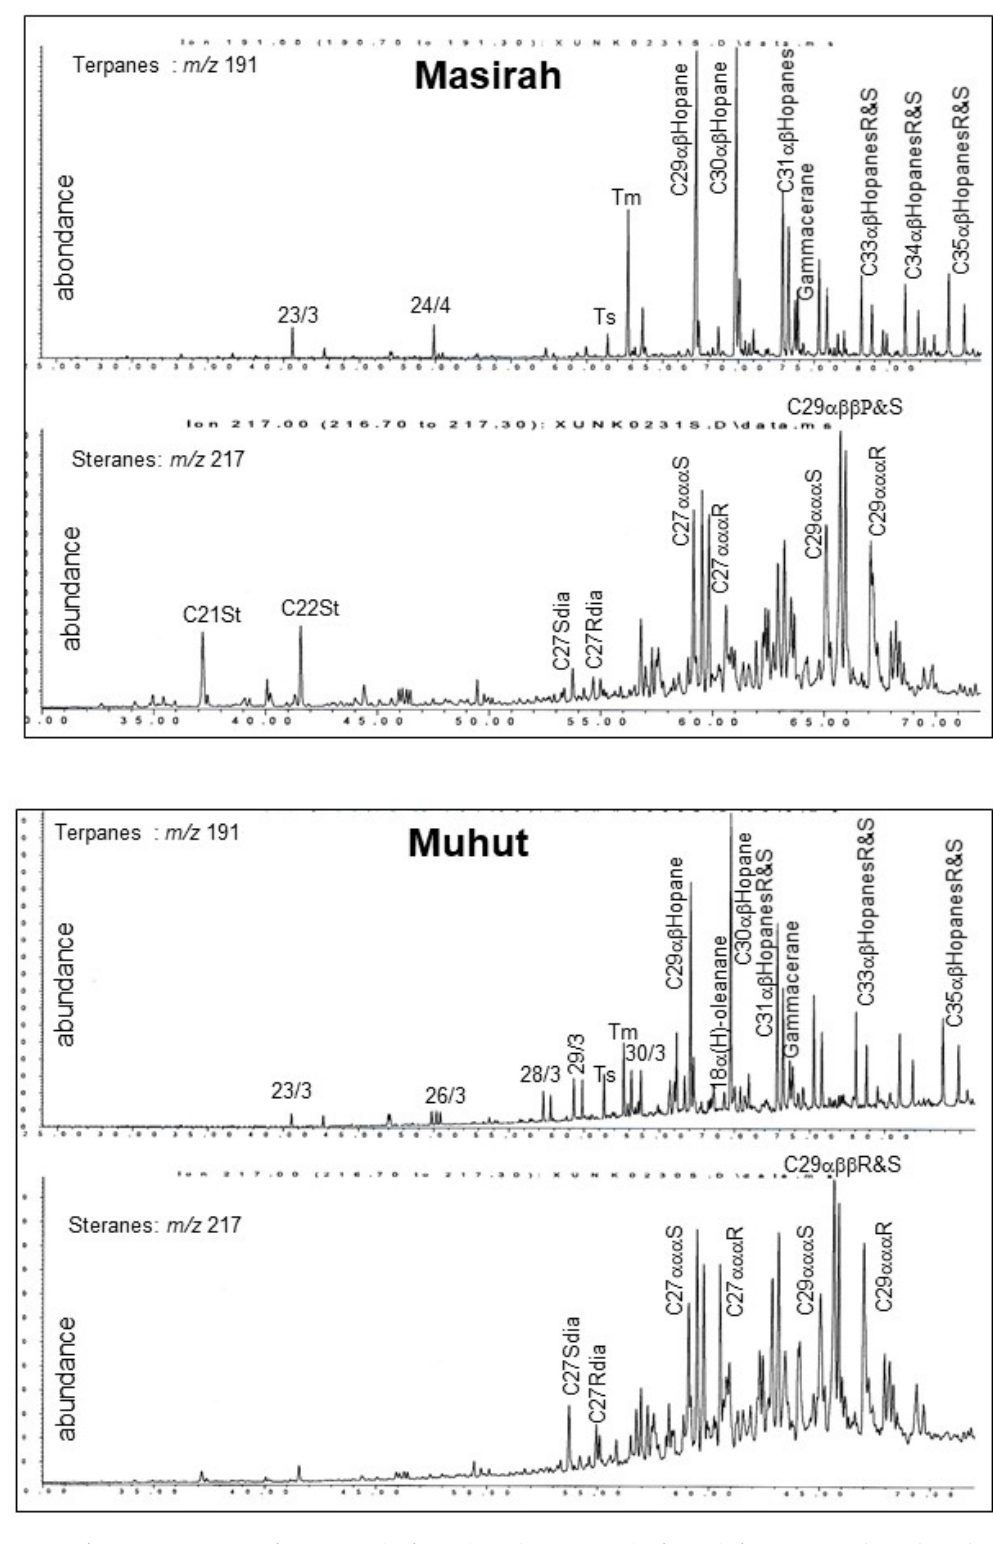
Figure 10. Mass fragmentograms of steranes ( m / z 217) and terpanes ( m / z 191) from Masirah and Muhut bitumens. Significance of abbreviations: C29 αβ hopane = 17 α ,21 β -30norhopane, C30 αβ hopane = 17 α ,21 β -hopane, C31 αβ hopaneR&S = 17 α ,21 β ,22S&R-30-homohopane, C35 αβ hopaneR&S = 17 α ,21 β -22S-29pentakishomohopane, C29 αββ R&S = 5 α ,14 β ,17 β - 20R + 20S-24ethylcholestane, C29 ααα R = 5 α ,14 α ,17 α -20R-24-ethylcholestane, Ts = 18 α -22,29; 30-trisnorneohopane, Tm = 17 α